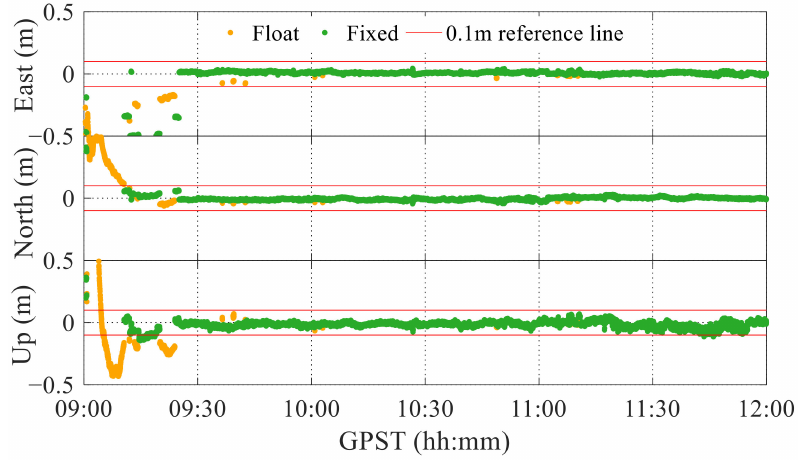
Figure 8. Results of partial ambiguity resolution for GPS L1 + Galileo E1 observations.